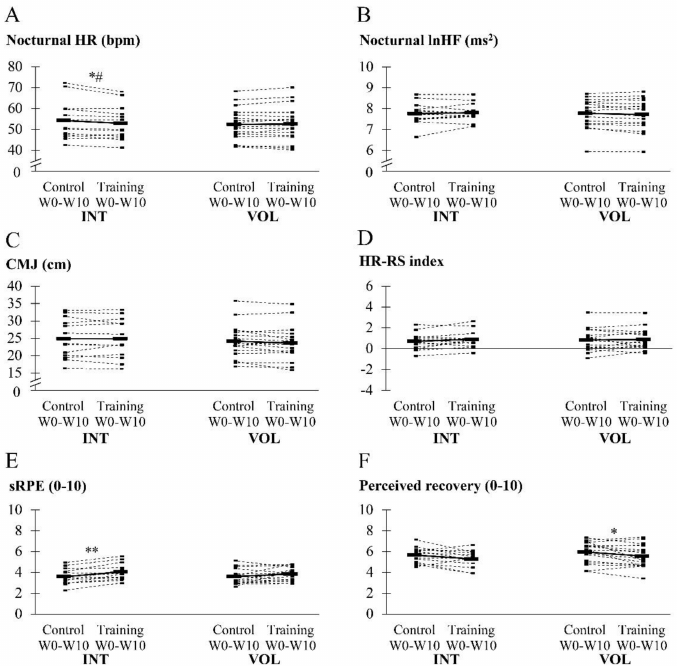
Figure 2. Individual average values during the control and training period in the nocturnal heart rate (HR) and heart rate variability (lnHF), countermovement jump (CMJ), heart rate-running speed index (HR-RS index), session RPE (sRPE) and perceived recovery. * p < 0.05 in within-group comparison to control, ** p < 0.01 in within-group comparison to control. # = p < 0.05 in between-group comparison with relative